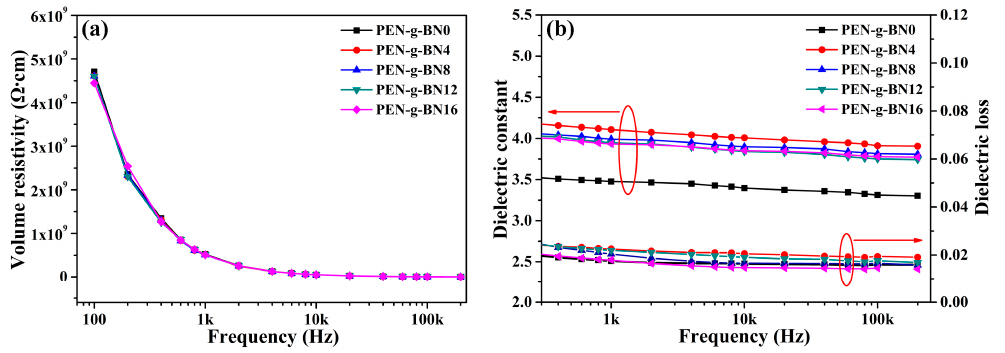
Figure 7. Insulation properties ( a ) and dielectric properties ( b ) of the PEN-g-BN hybrids.